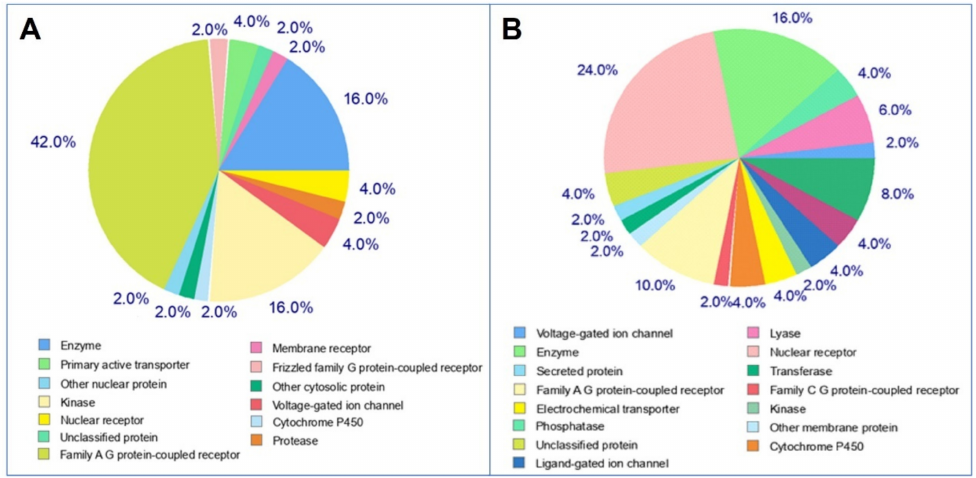
Figure 10. Pie-chart of top-50 of target predicted for selected molecules ( A : tomatidine, B : patchouli